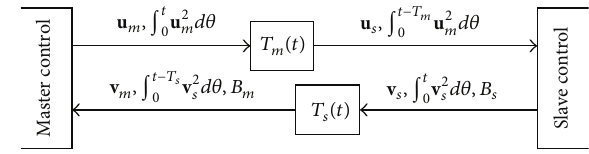
Figure 2: Flow of information between master and slave